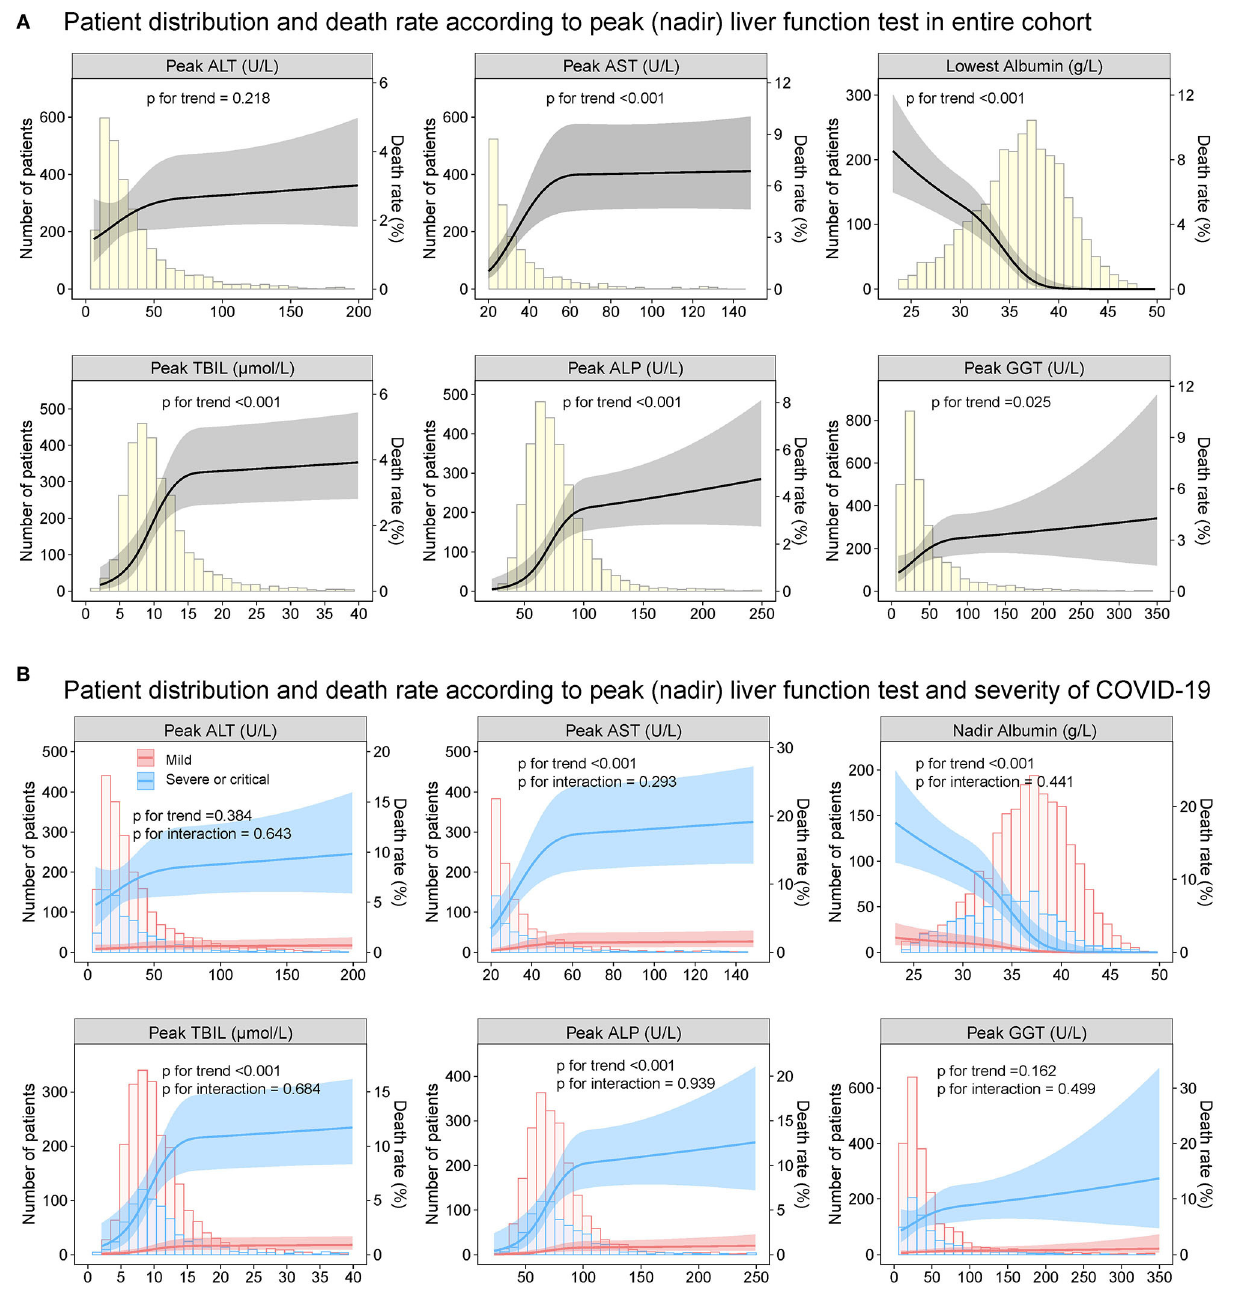
FIGURE 12 | Patient distribution and death rates according to peak (nadir) liver function test in entire cohort. Patient distribution and death rate according to peak ALT, peak AST, nadir albumin, peak TBIL, peak ALP, and peak GGT during hospitalization (A) in entire cohort (B) by severity of COVID-19 infection (mild vs. severe/critical). Restricted cubic splines were generated using logistic regression models. ALT, alanine aminotransferase; AST, aspartate transaminase; ALP, alkaline phosphatase; COVID-19, coronavirus disease 2019; GGT, gamma-glutamyltransferase; TBIL, total